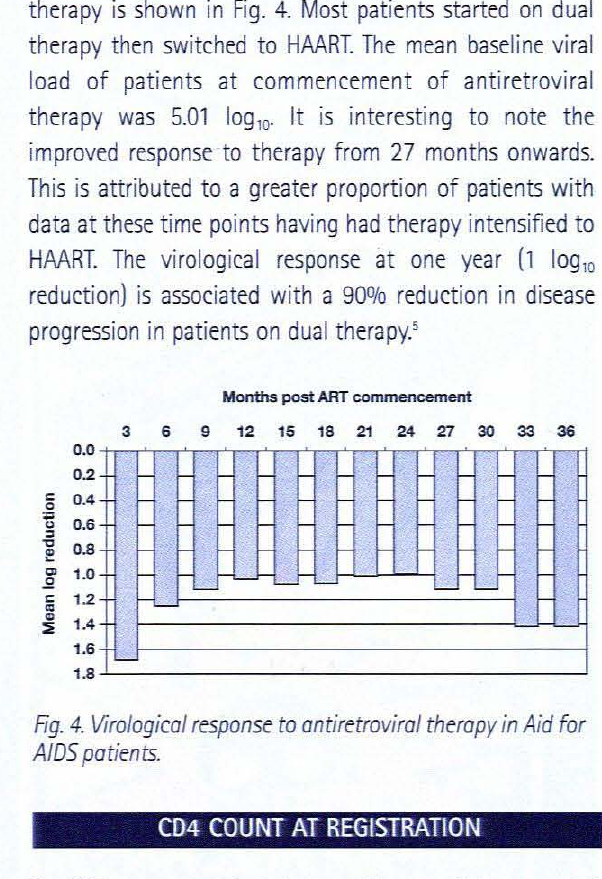
Fig. 5. Hospital admissions relative to commencement of ARI